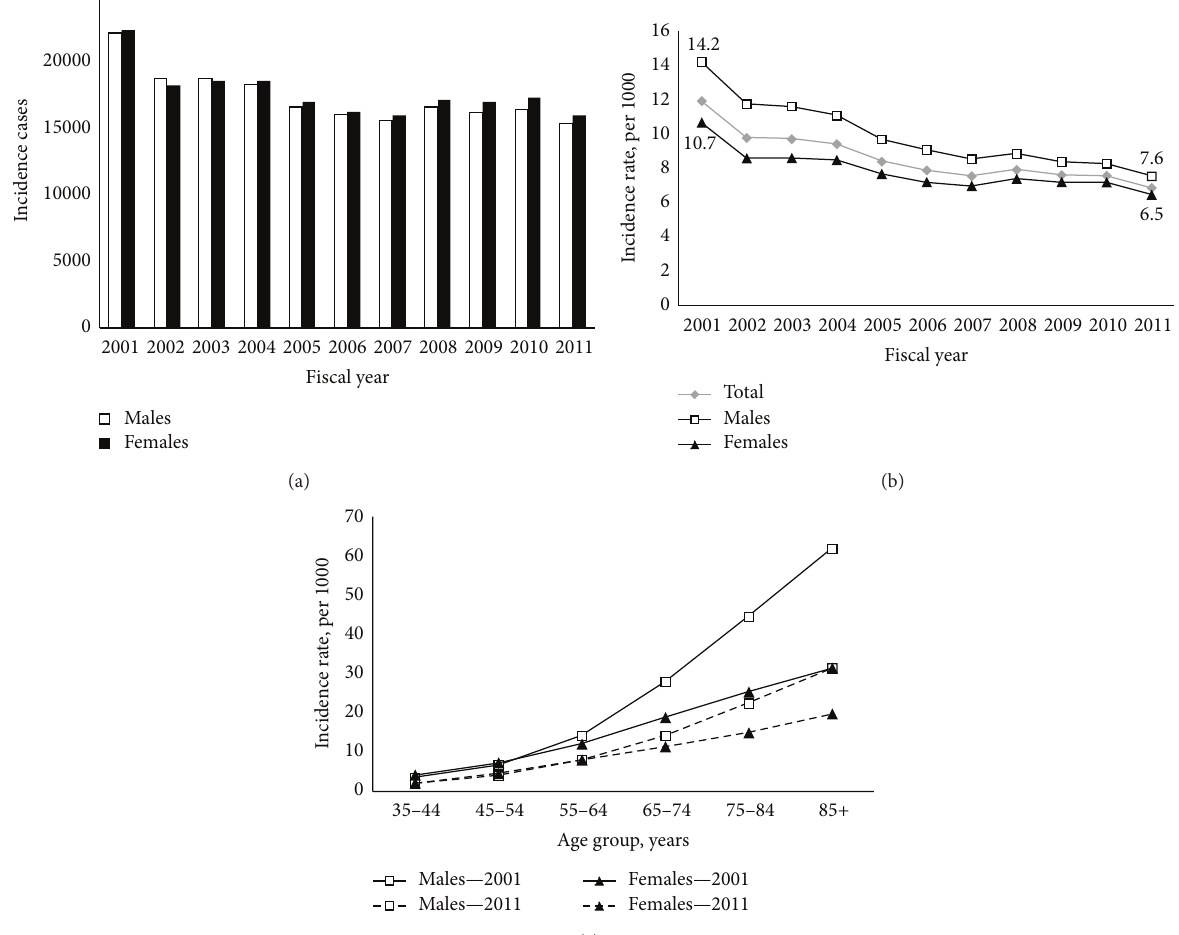
Figure 1: COPD incidence. (a) Number of incidence diagnosed COPD cases, 35 years and older, by sex, Quebec, 2001–2011. (b) Age- standardized COPD incidence rates, 35 years and older, by sex, Quebec, 2001–2011. (c) Age-specific COPD incidence rates, by sex, Quebec, 2001 compared to 2011